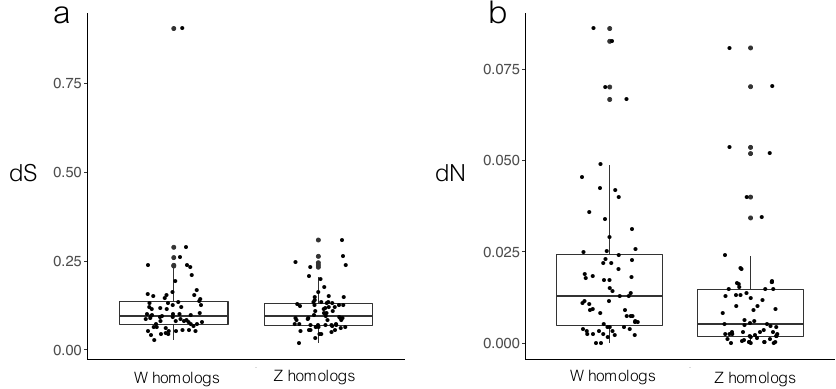
Figure 1. ( a ) Rate of synonymous substitutions (dS) and ( b ) non-synonymous substitutions (dN) between homologous genes in the zebra finch and the common whitethroat, i.e., zebra finch chromosome 4A genes and common whitethroat neo-W and neo-Z sequences. There was no statistical difference for dS ( p = 0.24), whereas dN differed between W and Z ( p < 0.001).